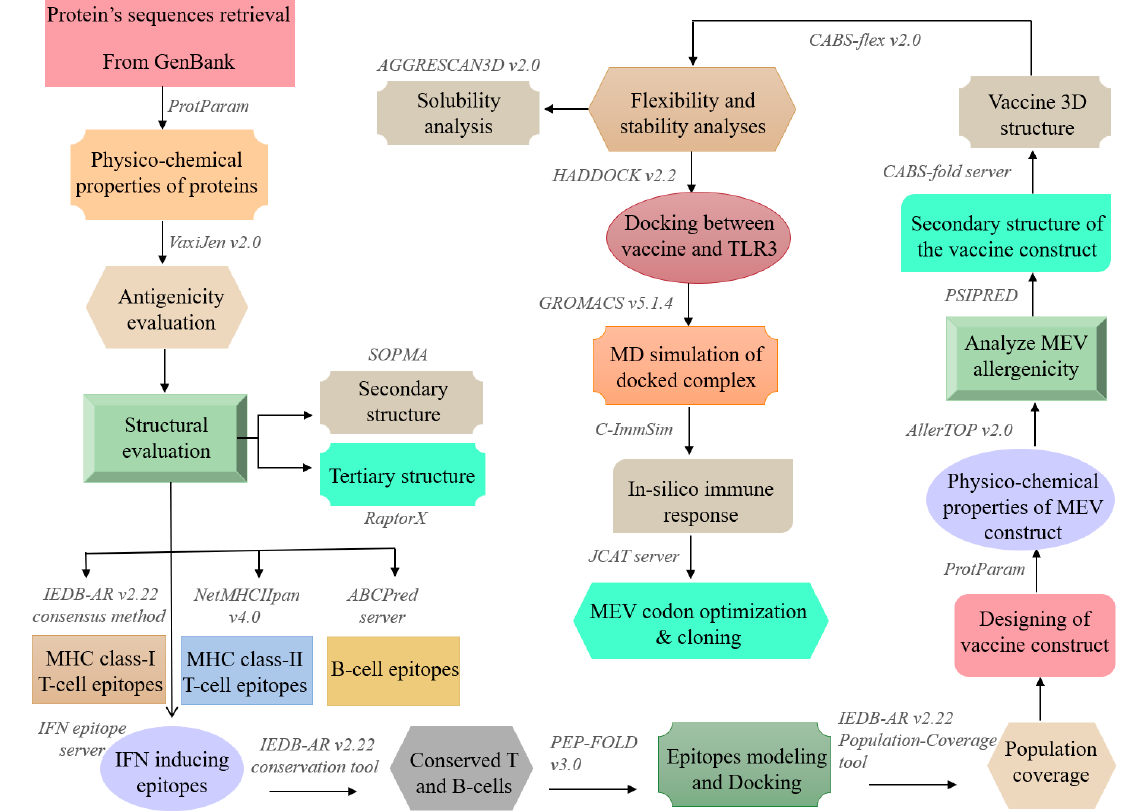
Figure 1. A schematic representation of methodology and tools used in the present study.